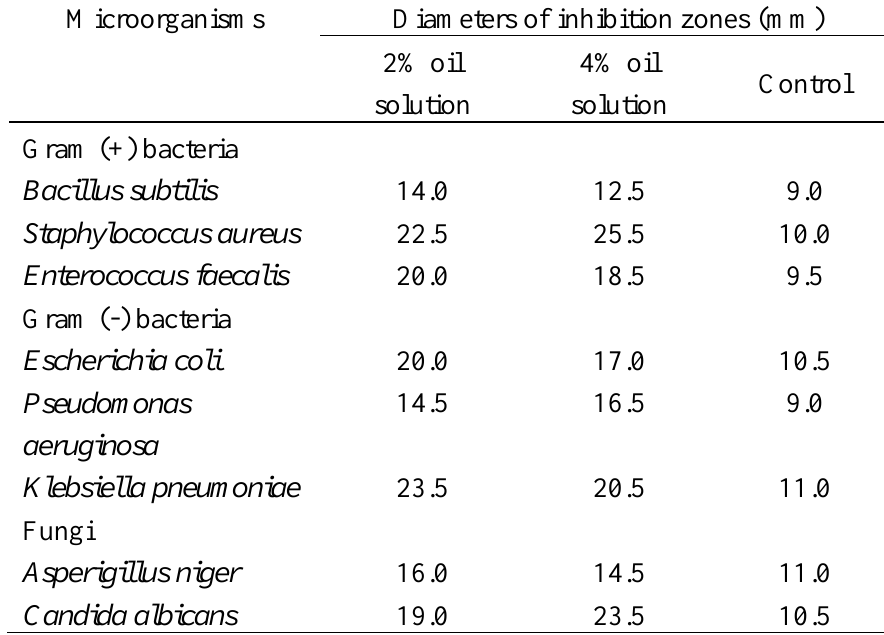
Table 3. Antimicrobial activity of the essential oil from A. trifida from Northeast